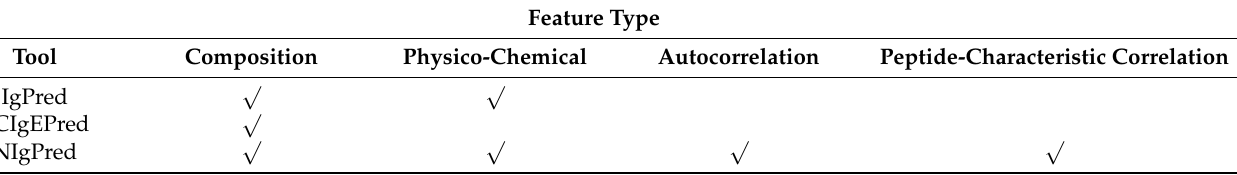
Table 2. Comparison of the features of different